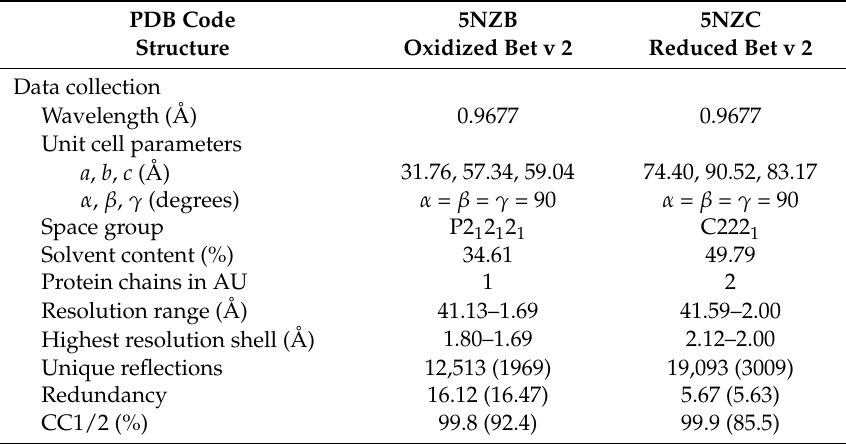
Figure 2. Crystal structures of Bet v 2. ( a ) Superimposition of the overall structure of oxidized and reduced forms. Bet v 2 oxidized and reduced forms are presented in cyan and yellow, respectively. Cys13 and Cys117 are shown in a stick representation; ( b ) Close-up view of the terminal region of oxidized Bet v 2 with disulfide bridge formed and ( c ) Close-up view of the terminal region of reduced Bet v 2 with cysteines in an open conformation. The density is displayed by 2Fo-Fc Map ( σ = 1). Table 2. Crystallographic data and refinement statistics.